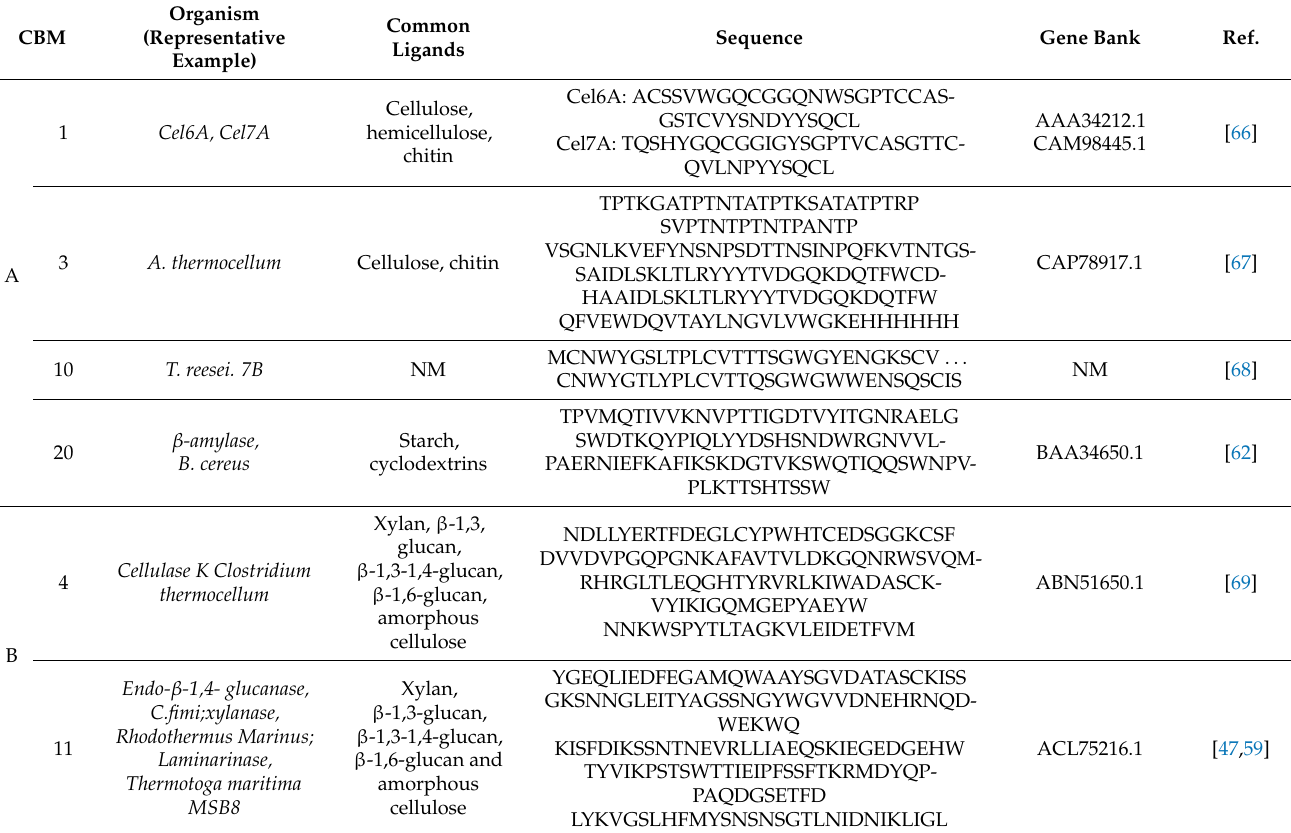
Table 1. Summary of the CBMs used for detection and the sequence of different